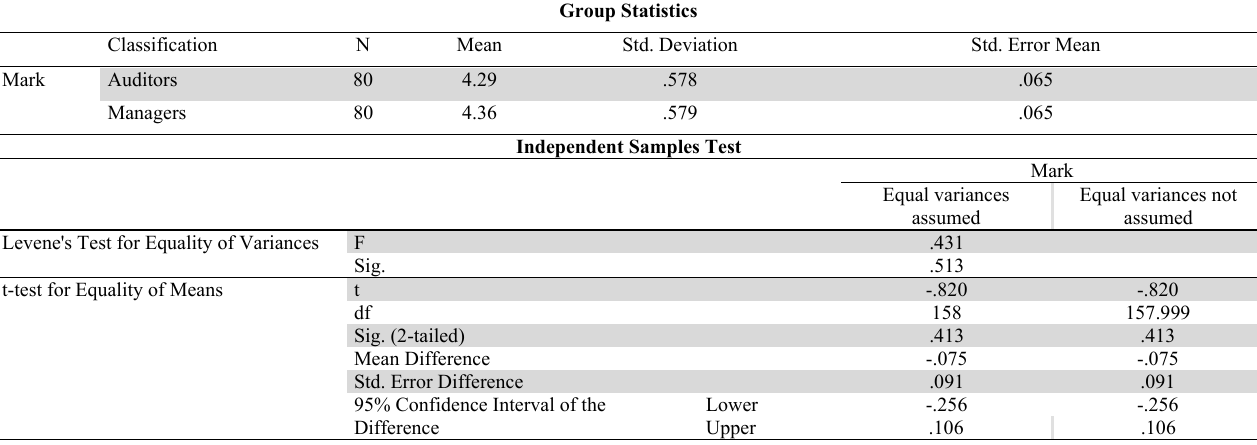
Evaluation of the impact of the State on the application of the international financial reporting standards for SMEs from the perspective of auditors and managers